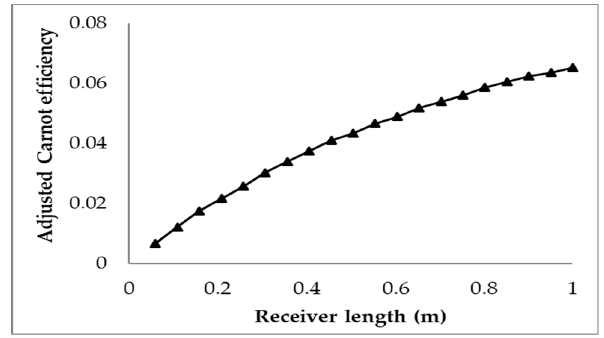
Figure 6. Adjusted Carnot efficiency for varying receiver length.